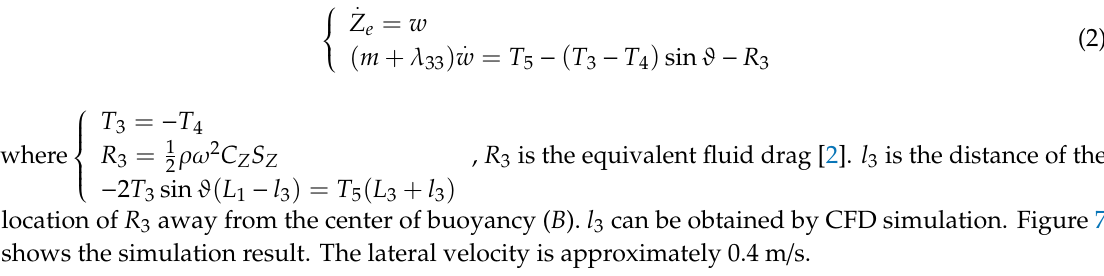
Figure 6. Force analysis when moving lateral.